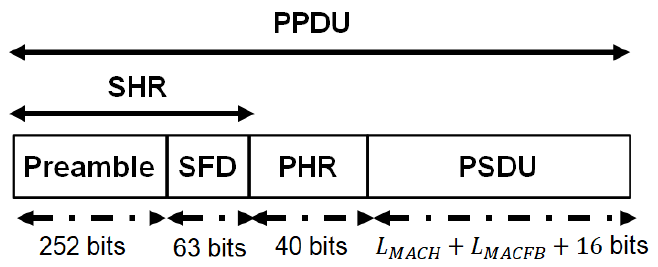
Figure 2. PPDU structure.